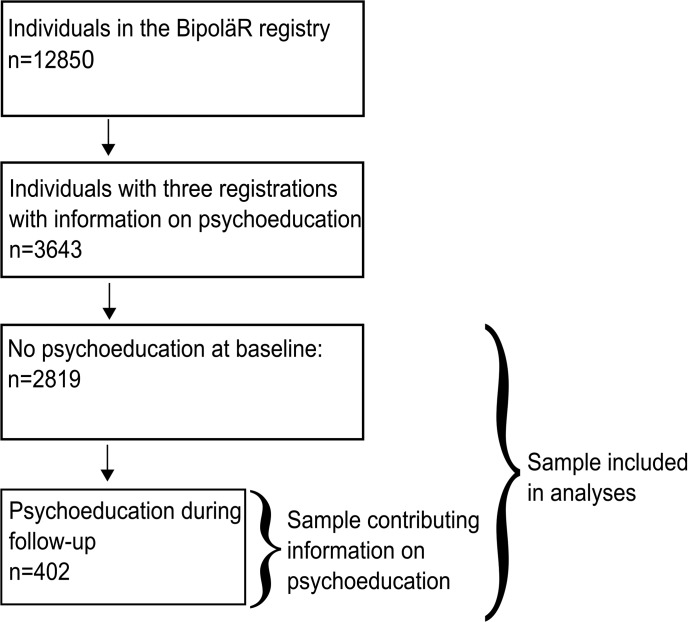
Sample selection.